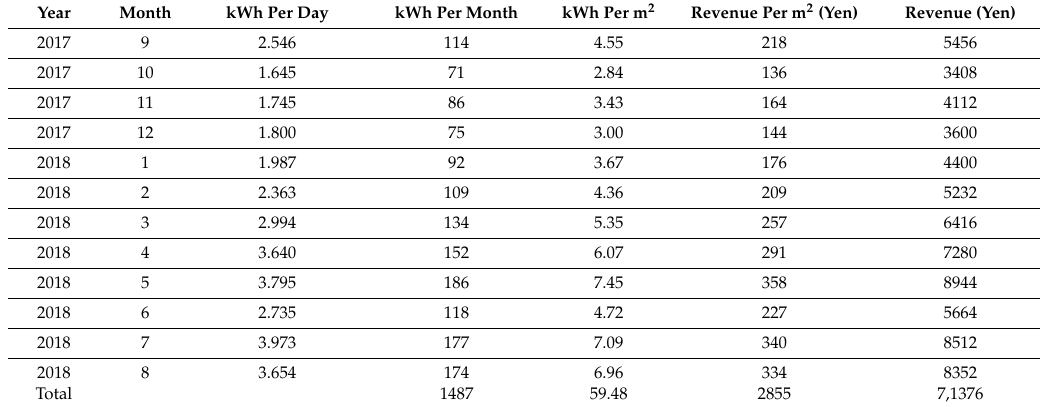
Table 5. Power output (kWh) of stilt-mounted agrivoltaic PV modules in the low-density configuration